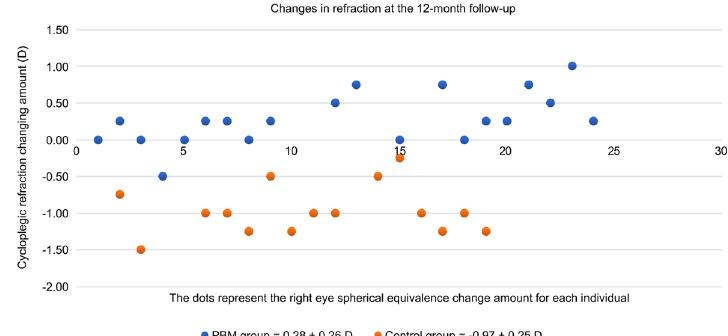
Figure 3. Changes in refraction individually at 12-month visit. PBM photobiomodulation therapy, Control single vision spectacles only.